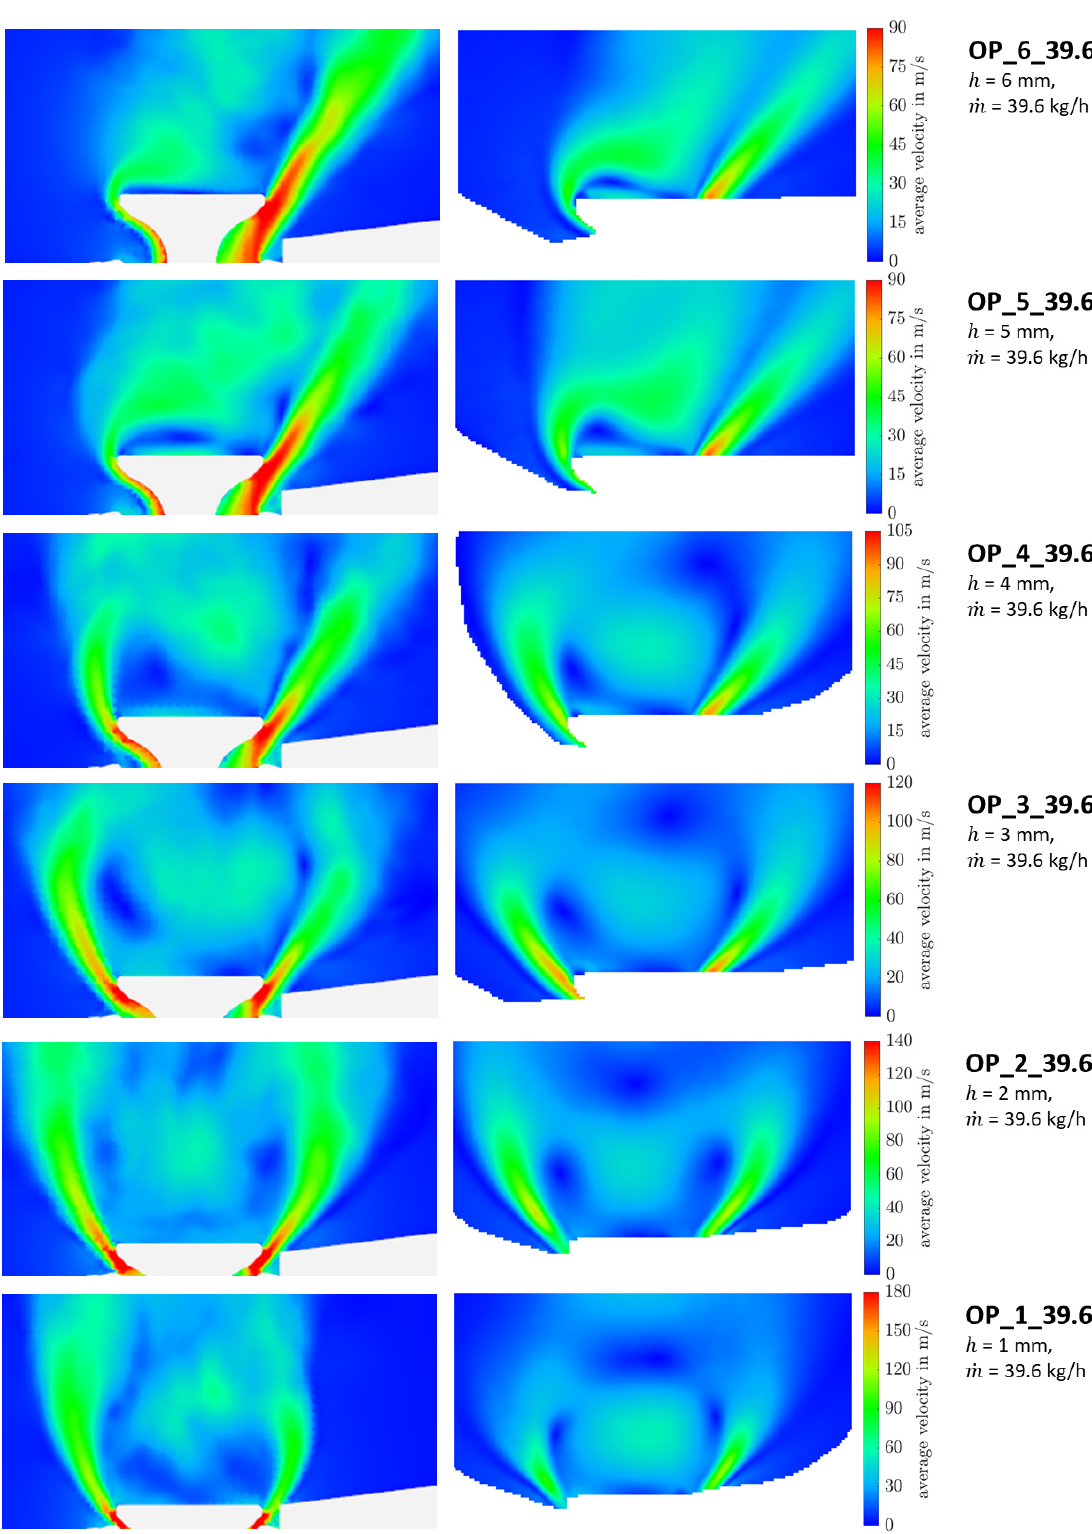
Figure 12. Comparison of time-averaged velocity fields for LES ( left ) and PIV ( right ) for the valve lift variation (note: adjusted colour coding).